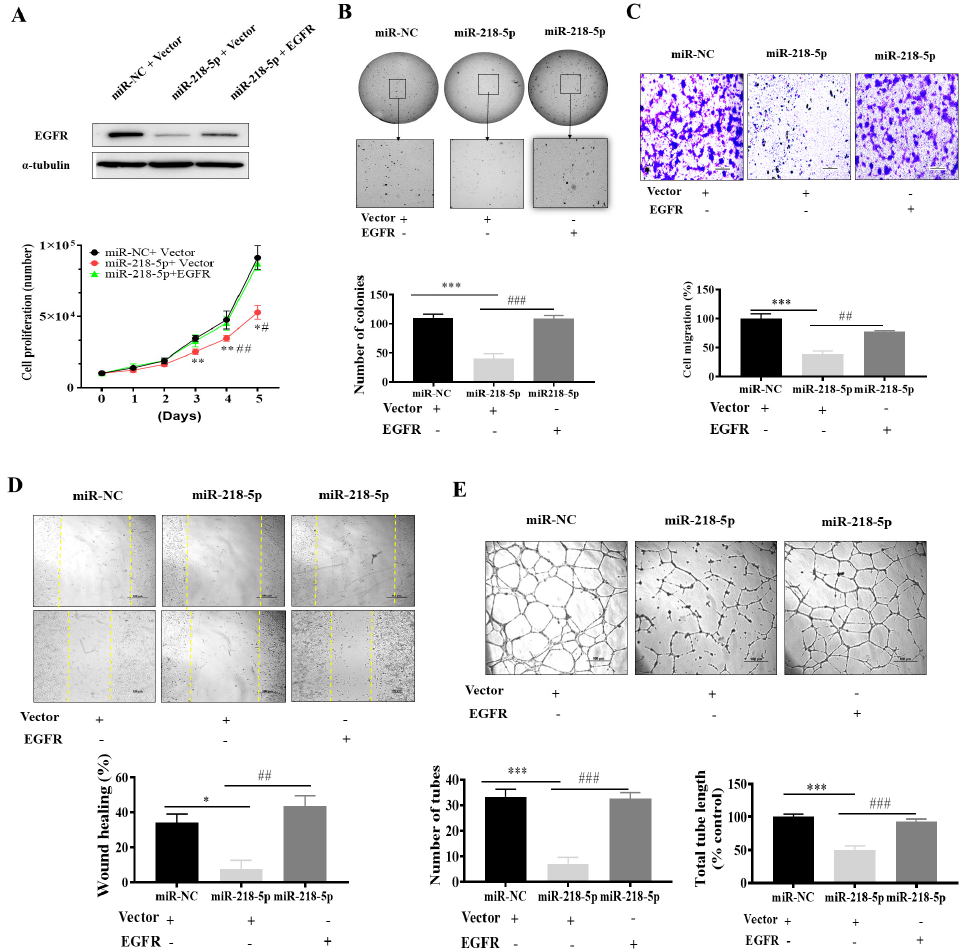
Figure 5. MiR-218-5p inhibited cell proliferation, colony formation, migration, and tube formation, which was recovered by forced expression of EGFR. As-T cells stably expressing miR-NC and miR- 218-5p were transiently transfected by empty vector or vector carrying EGFR ORF. Immunoblotting assay was performed to detect EGFR and β -actin proteins after 72 h of post-transfection. ( A ) After 24 h of transfection, the cells were seeded into a 12-well plate, and cell proliferation assay was performed by manually counting live cells for 5 days. ( B ) Soft agar colony formation assay. ( C ) Cell migration using transwell assay. Scale: 100 μ m. ( D ) Wound healing assay in the six-well plate. ( E ) HUVECs tube formation assay. Data were shown using line graphs and bar graphs from three independent experiments. The * denotes a significant difference between miR-NC+ empty vector and miR-218-5p + empty vector groups, and # represents a significant difference between miR-218-5p + empty vector and miR-218-5p + EGFR groups. * and # p < 0.05, ** and ## p < 0.01, *** and ### p < 0.001. The original western blots of this figure is Figure